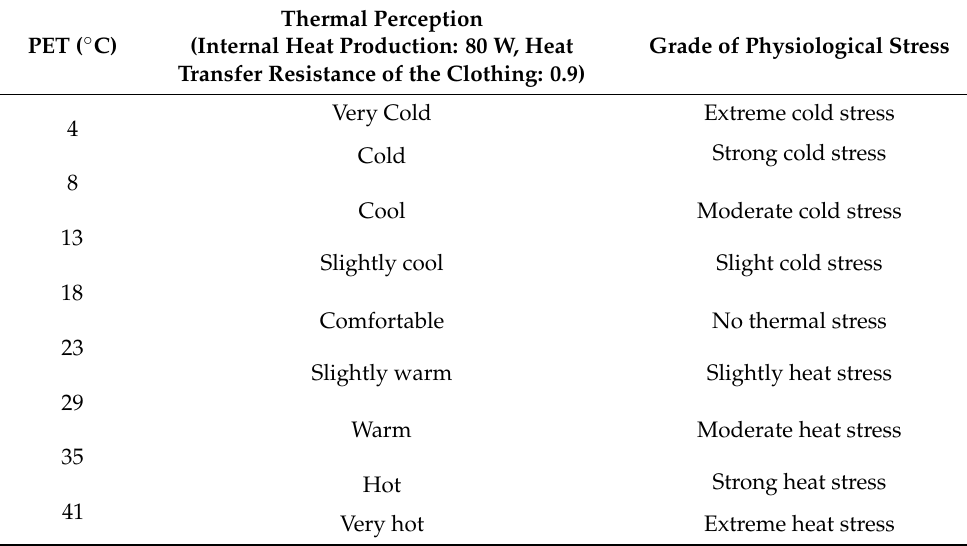
Table 1. Ranges of the thermal index of PET for different grades of thermal perception by human [13]. Thermal Perception PET ( ◦ C) (Internal Heat Production: 80 W, Heat Grade of Physiological Stress Transfer Resistance of the Clothing: 0.9) Very Cold Extreme cold stress 4 Cold Strong cold stress 8 Cool Moderate cold stress 13 Slightly cool Slight cold stress 18 Comfortable No thermal stress 23 Slightly warm Slightly heat stress 29 Warm Moderate heat stress 35 Hot Strong heat stress 41 Very hot Extreme heat